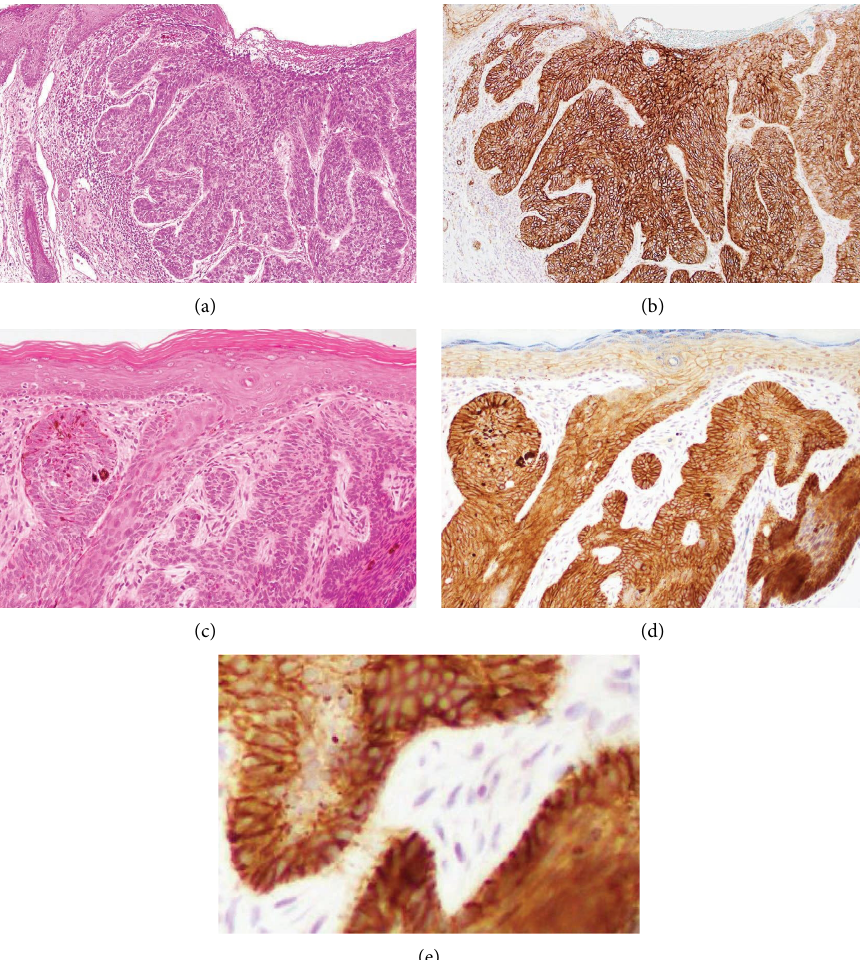
Figure 2: Representative immunohistochemical results for claudin 1 (b, d, and e) and corresponding HE-stained sections (a and d) in lower- grade BCC. (a) Microphotograph of nodular BCC. (b) Neoplastic cells are difusely and strongly positive in cytoplasm and membrane. (c) Microphotograph of BCC and adjacent epidermis. (d) BCC shows strong membranous and cytoplasmic reactivity in the periphery of tumour nests. Reactivity appears more intense in BCC than in normal epidermis (arrow). Claudin 1 was positive with weaker staining intensity in the central area of tumour nest (arrow head). (e) Positivity is seen in the membrane and